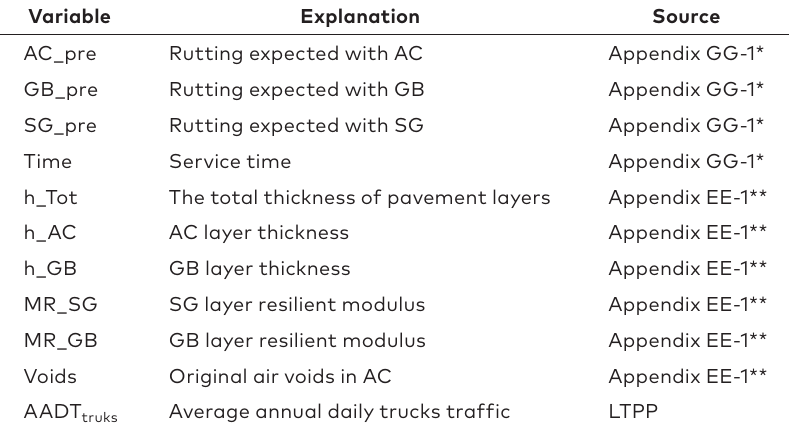
Table 3. Part of the data from Table 4 in Appendix